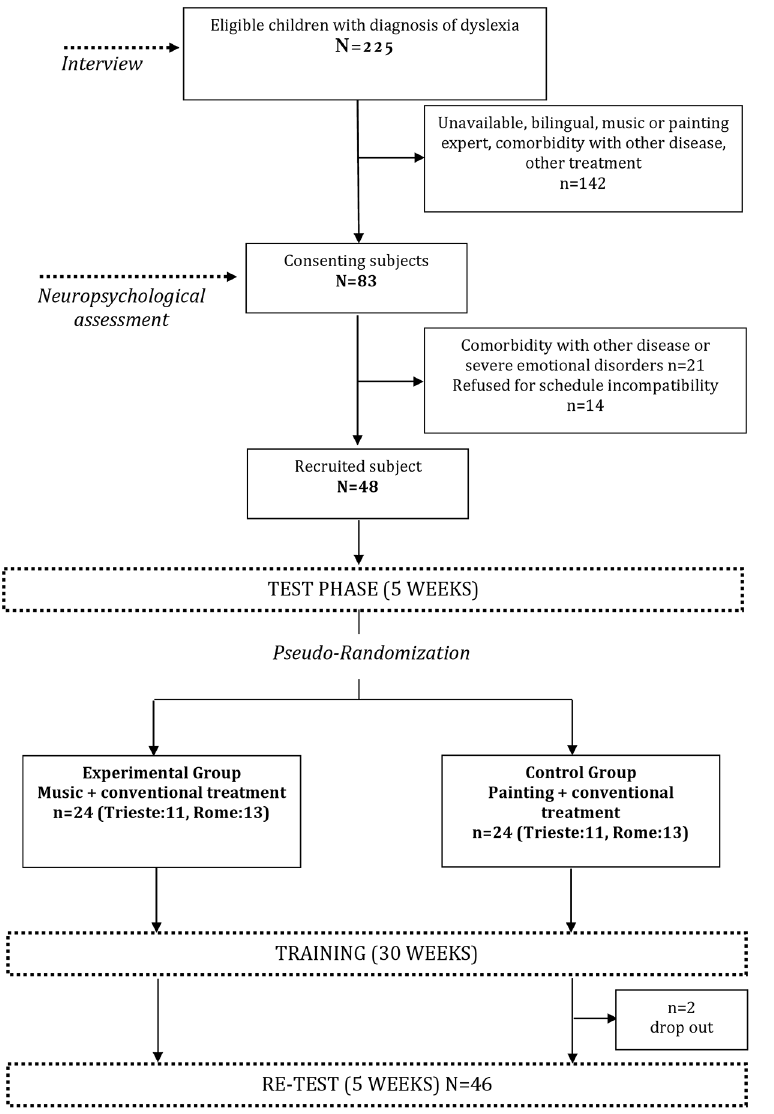
Fig 1. Flow chart illustrating participants ’ recruitment and experimental